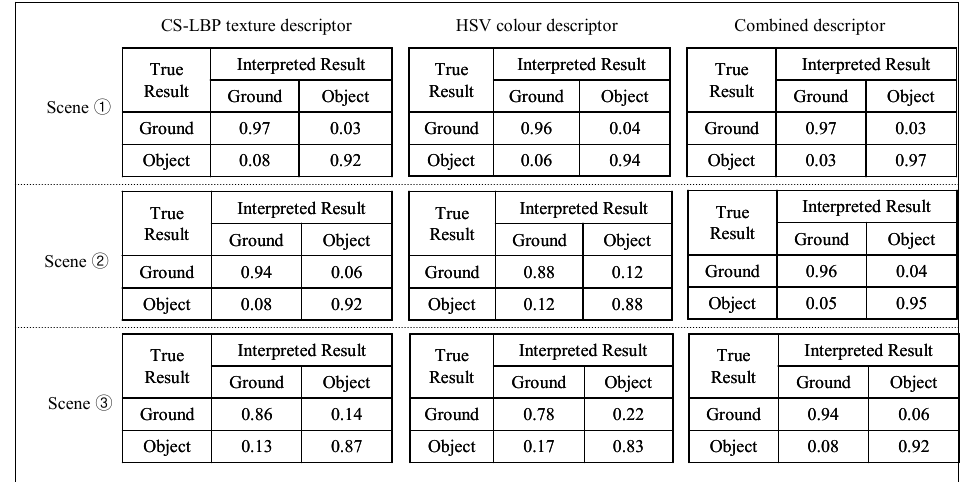
Figure 23. Far-field model performance using different appearance descriptors.